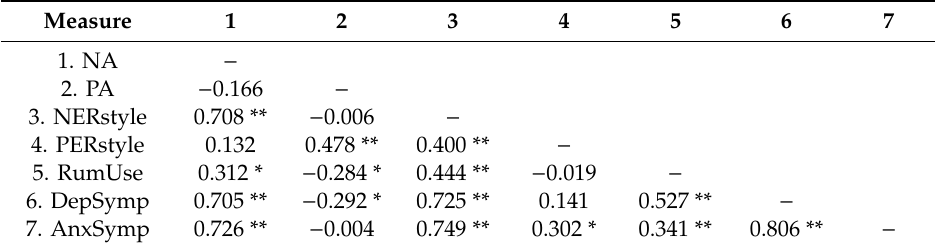
Table 2. Zero-order, pairwise correlations between all measures of interest.